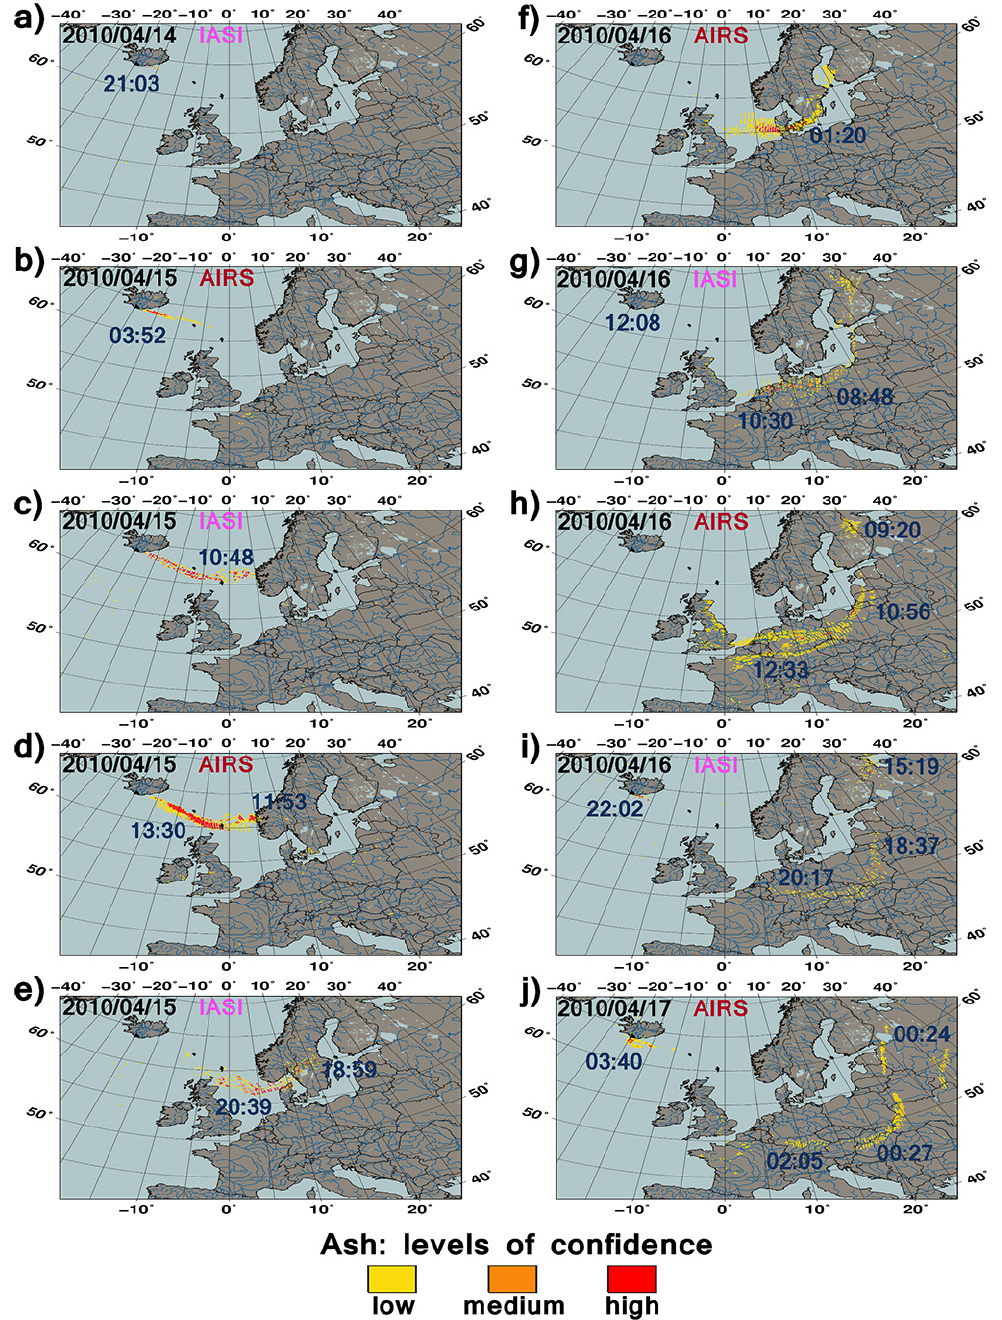
Fig. 19. Ash index images from thermal IR sensors (AIRS and IASI-A) during the eruption of the Eyjafjallajökull Volcano (Iceland) in spring